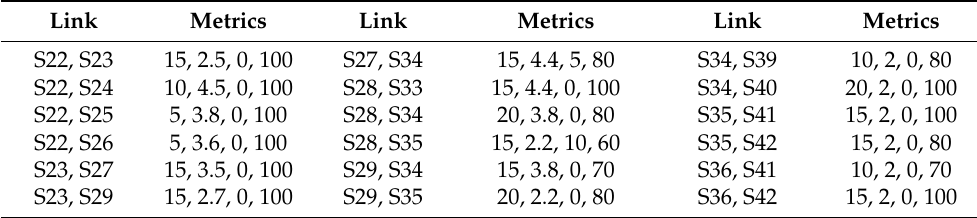
Table A2. Controller B Network Node metrics in the simulation